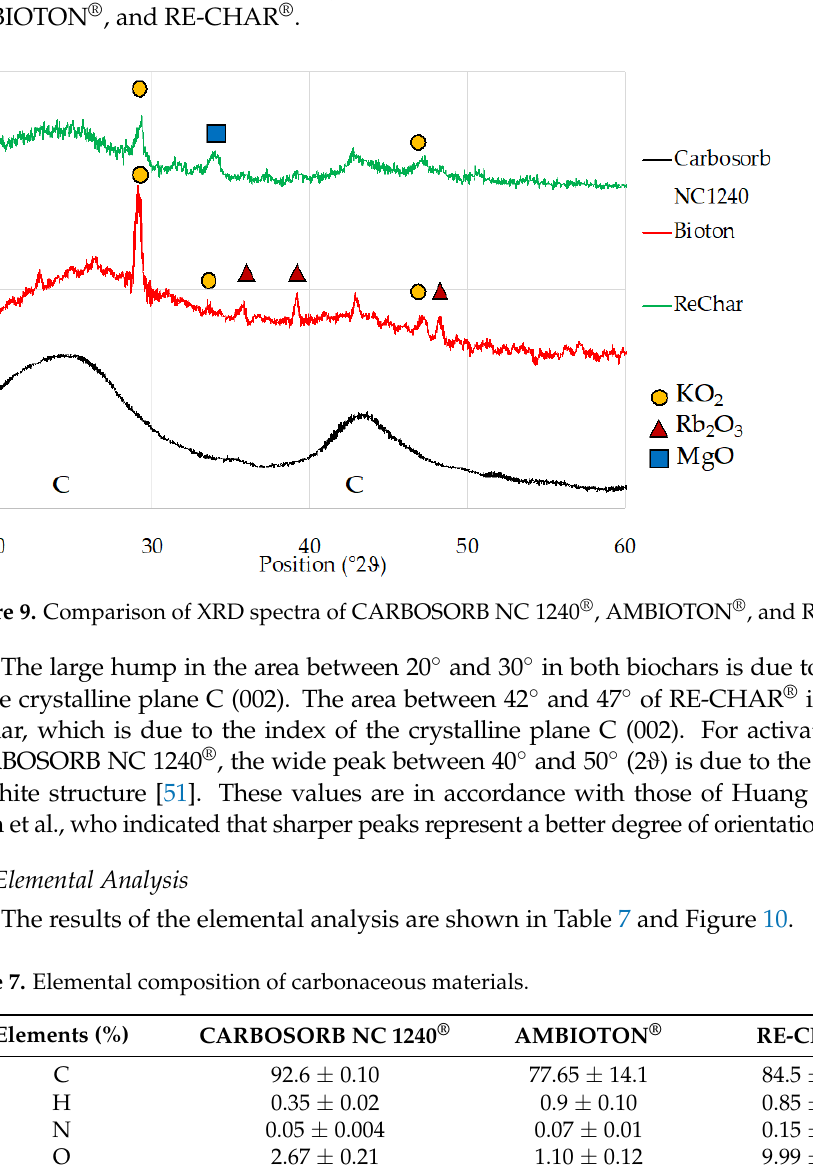
Figure 8. XRD spectra of CARBOSORB NC 1240 ® ( a ), AMBIOTON ® ( b ), and RE-CHAR ® ( c ).